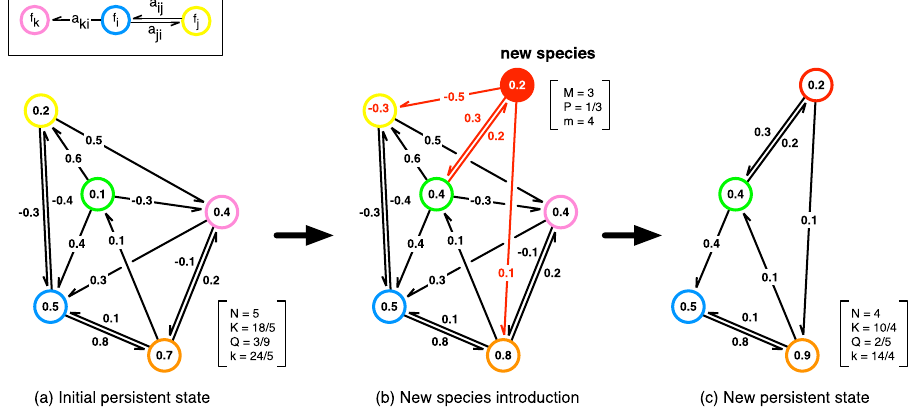
Figure 1. The temporal evolution of a partially bidirectional model. ( a ) All the species have positive fitness and hence the system is in a persistent state. ( b ) The introduction of a new species (red). In this case the inclusion leads to the extinctions of a resident species (yellow) and that extinction triggers another extinction of a species, which is not directly connected to the newly introduced species (magenta). ( c ) Finally, the system reaches to a new persistent state. The numbers in the square brackets demonstrate the control parameters; M : the number of interacting species of the newly introduced species, P : the ratio of the bidirectional relation in the initially assigned interactions, and m = (1 + P ) M : unidirectional link degree of the newly introduced species, and observables of the emerging network; N : the number of species, K : average number of interacting pairs per species in the system, Q : the ratio of the bidirectionally interacting pairs to the all interacting pairs in the system, and k = (1 + Q ) K : average unidirectional link degree of the